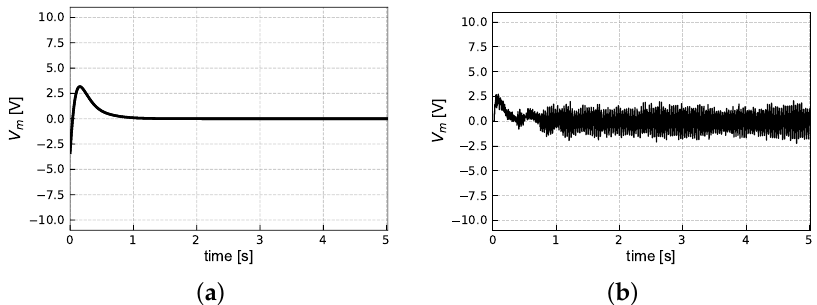
Figure 13. Case C1: Angular positions: ( a ) simulation, ( b ) experiment.